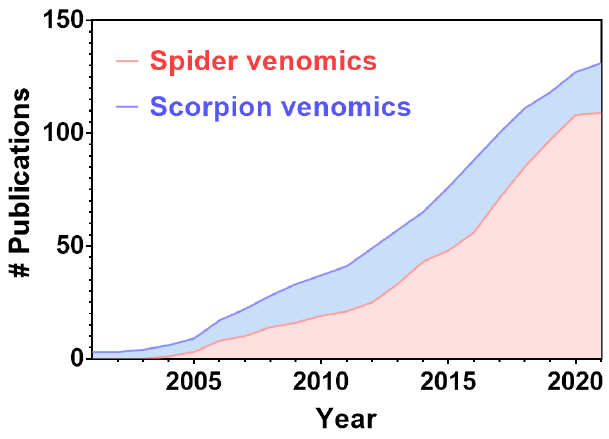
Figure 1. Number of publications on scorpion venomics and spider venomics. Results were retrieved from PubMed (https://pubmed.ncbi.nlm. nih.gov/) by March 2021 using the following search parameters: “(scorpion venom) AND (proteome)” for scorpion venomics or “(spider venom) AND (proteome)” for spider